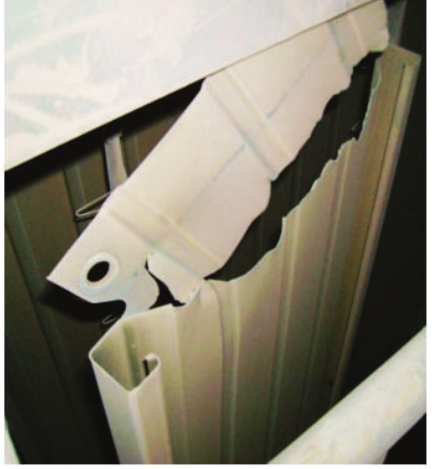
Figure 4: The location of collecting plate ruptures.